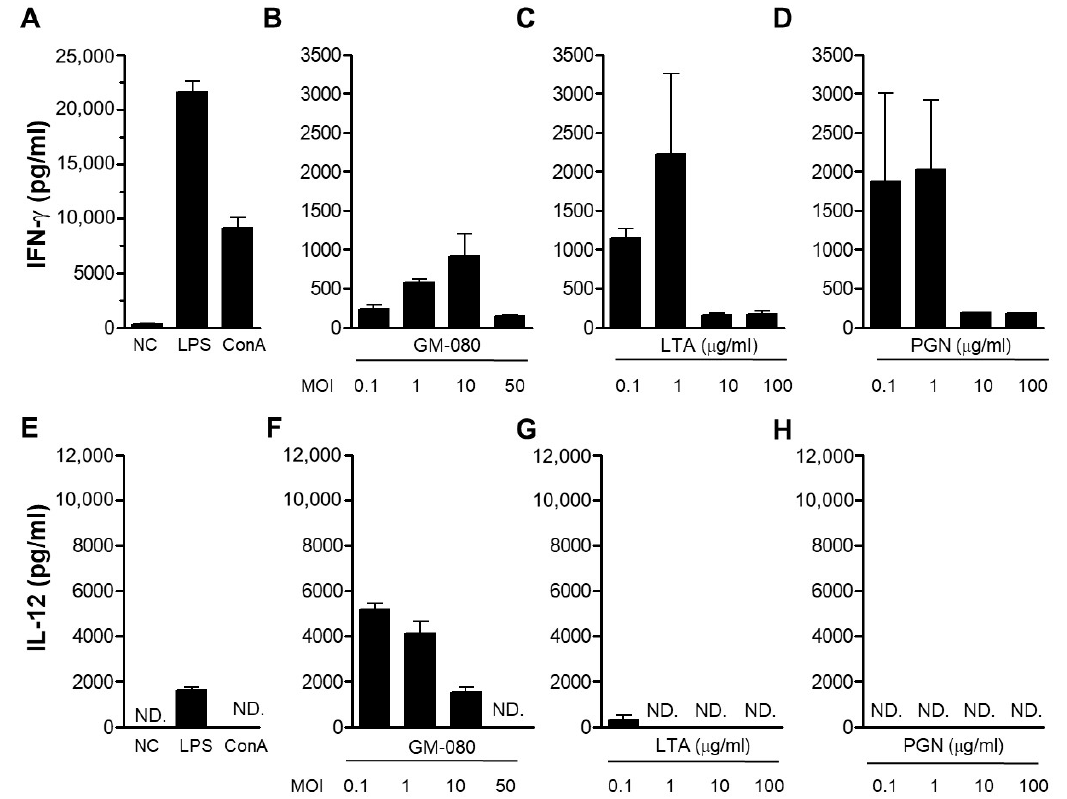
Figure 2. Effects of GM-080 preparations and cell wall compartments in Th1 cytokines production of mouse splenocytes. We seeded 4 × 10 5 mouse splenocytes into a 48-well plate, followed by treatment with viable GM-080 preparation with the indicated MOI or cell wall compartments purified from GM-080 (LTA and PGN) for 48 h. The culture supernatants were then harvested, and INF- γ ( A – D ) or IL-12 ( E – H ) production was determined using commercial ELISA kits. LPS (1 µ g/mL) or ConA (1 µ g/mL) was used as the positive control. N.D., not